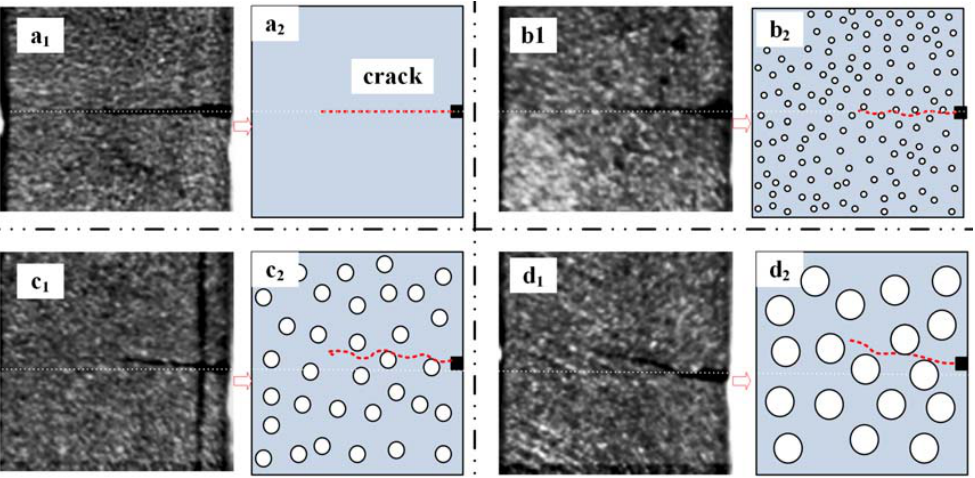
Figure 14. The mechanism of particle size effect on the dynamic fracture toughness: ( a 1 , a 2 ) neat epoxy; ( b 1 , b 2 ) 50 nm Al 2 O 3 ‐ filled epoxy (1 wt %); ( c 1 , c 2 ) 100 nm Al 2 O 3 ‐ filled epoxy (1 wt %); ( d 1 , d 2 ) 200 nm ( b 1 , b 2 ) 50 nm Al 2 O 3 -filled epoxy (1 wt %); ( c 1 , c 2 ) 100 nm Al 2 O 3 -filled epoxy (1 wt %); ( d 1 , d 2 ) 200 nm Al 2 O 3 ‐ filled epoxy (1 wt %). Al 2 O 3 -filled epoxy (1 wt